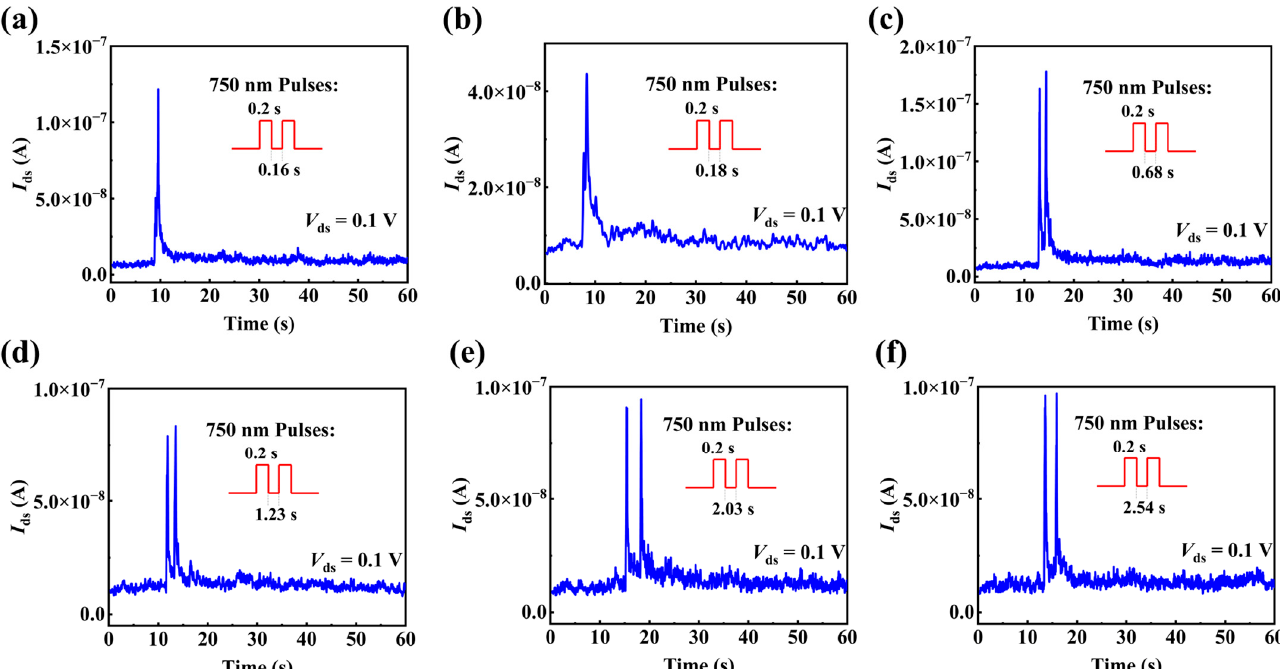
Figure 7. The post-synaptic current (PSC) of the P(VDF-TrFE)-coated InAs NW optical synapse stimulated by paired light pulses with the wavelength of 750 nm, intensity of 26.7 W/cm 2 , duration time of 0.2 s and different interval time ( a ) 0.16 s, ( b ) 0.18 s, ( c ) 0.68 s, ( d ) 1.23 s, ( e ) 2.03 s, ( f ) 2.54 s.